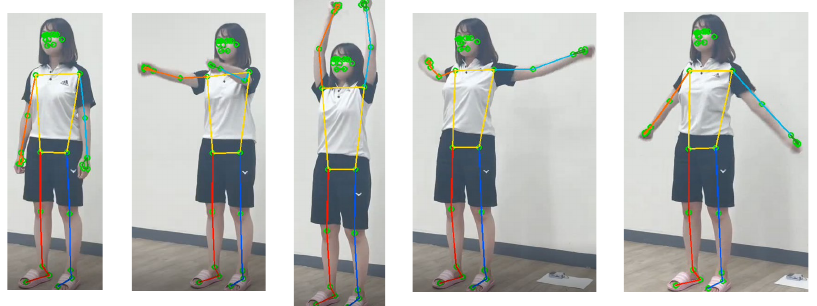
Figure 4. MPP execution results for the motion of raising the arm upward and then lowering it to the side.